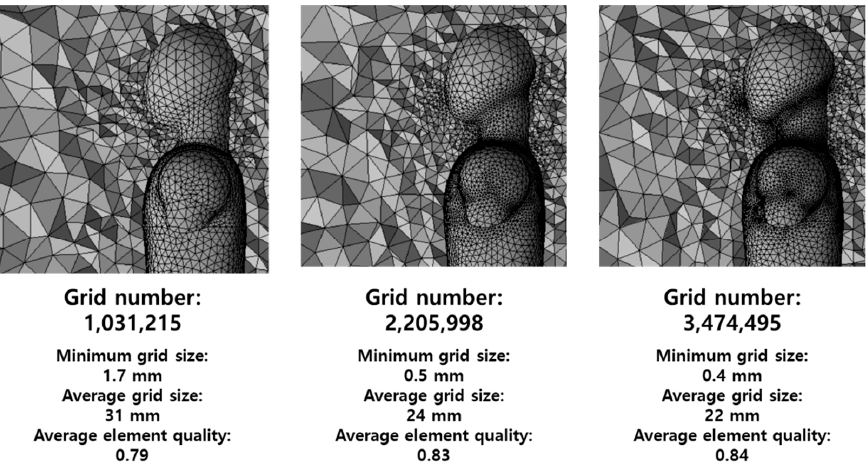
Figure 4. Grid-dependency tests of ( a ) droplet mass and ( b ) maximum and average velocity.